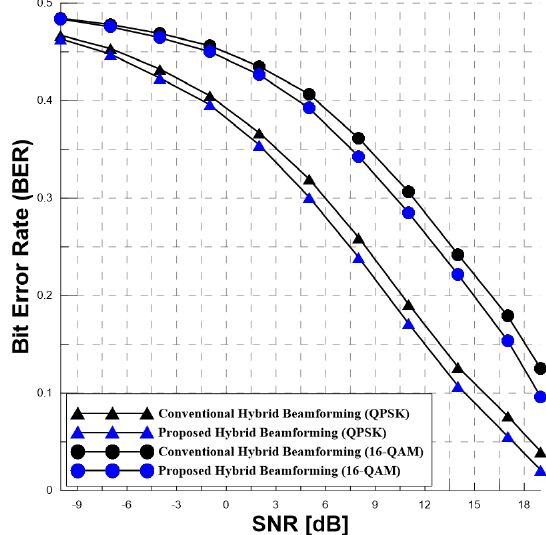
Figure 10. The bit error rate of the hybrid beamforming schemes, N t =